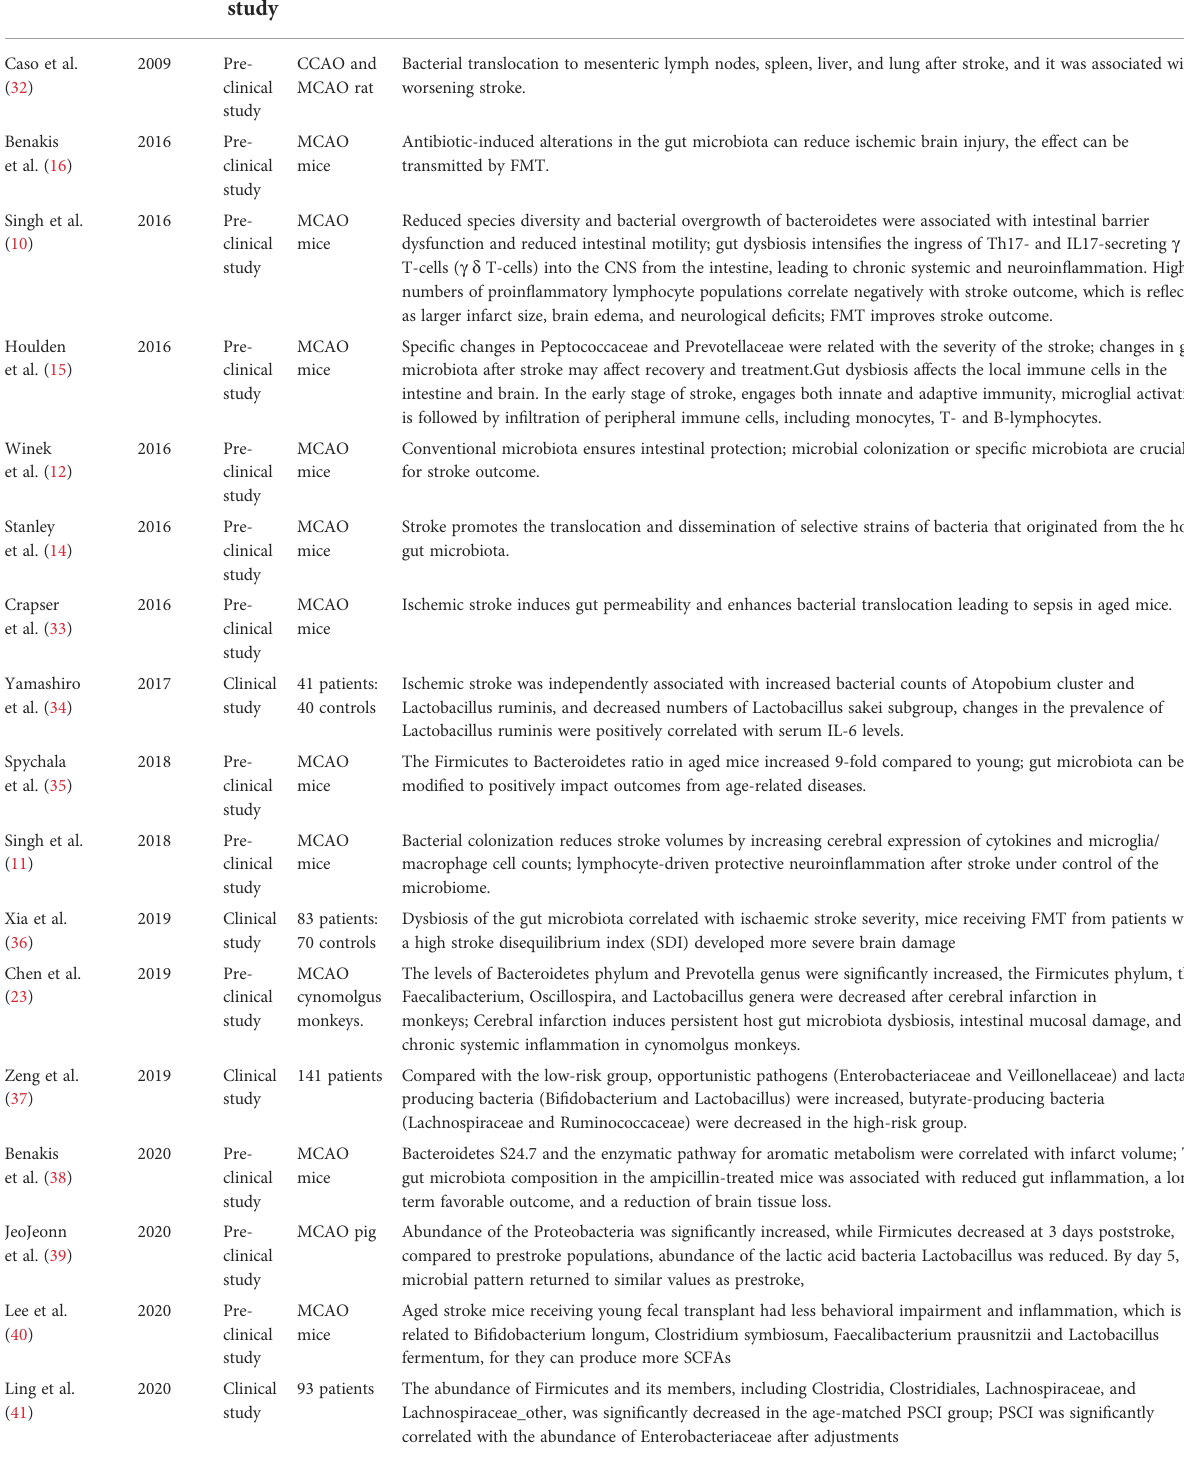
TABLE 1 Summarizes the pre-clinical and clinical evidences regarding the relationship between gut microbiota and ischemic